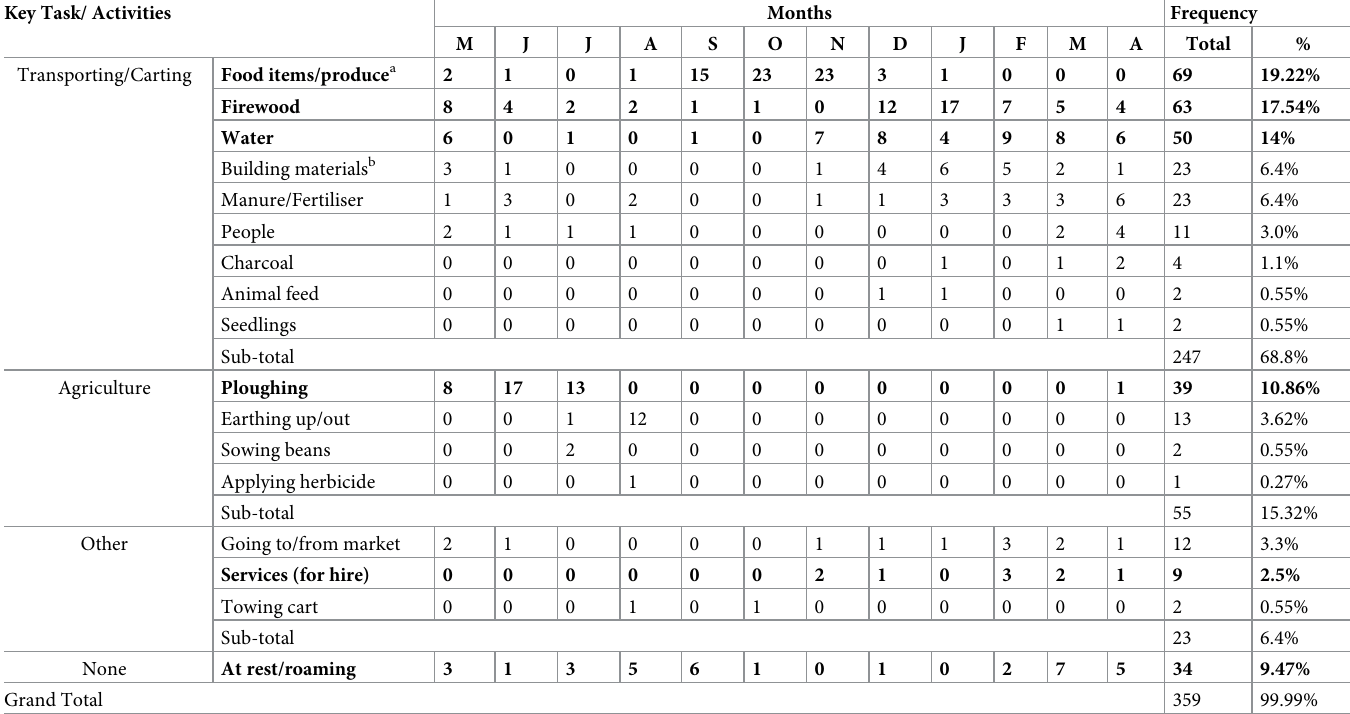
Table 2. Frequencies of key donkey tasks/activities per month. Source: Maggs, 2022, survey data [1]. Key Task/